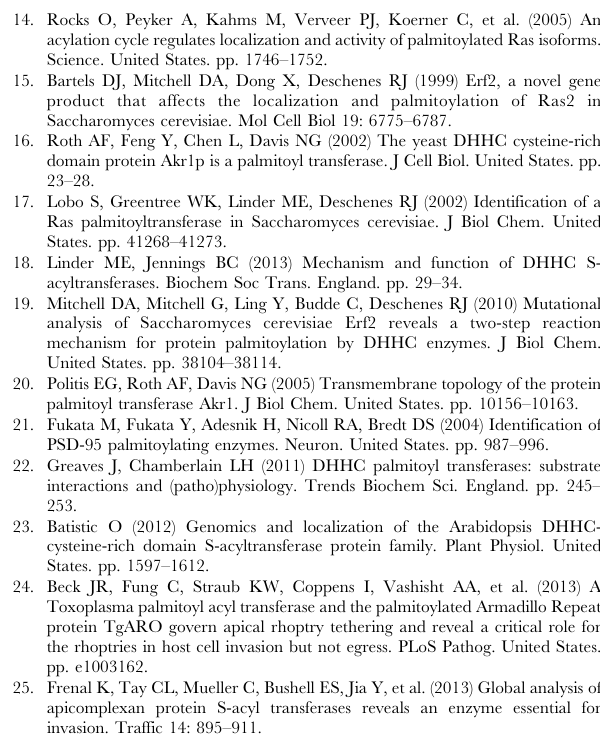
Figure S1 Expression of HCNCp-V5 in Giardia growing and encysting parasites. Western blotting performed on total protein extracts from hcncp-V5 transgenic trophozoites (T) or hcncp-V5 transgenic encysting trophozoites (ET). Expected size is indicated in brackets. Relative molecular weights of protein standards (kDa) are indicated on the left. Figure S2 The zoomed subclade containing gla_8619, gla_6733, gla_1908, and gla_8711 (A) or EAA36893 (B) from the phylogenetic tree presented in figure 4. Sequence taxonomic identity is displayed with colors as described in figure 4. Figure S3 The zoomed subclade containing gla_9529 from the phylogenetic tree presented in figure 4. Sequence taxonomic identity is displayed with colors as described in figure 4. Figure S4 The zoomed subclade containing gla_16928 (A) or gla_96562 (B) from the phylogenetic tree present- ed in figure 4. Sequence taxonomic identity is displayed with colors as described in figure 4. Figure S5 The zoomed subclade containing gla_2116 from the phylogenetic tree presented in figure 4. Sequence taxonomic identity is displayed with colors as described in figure 4. Figure S6 Differential expressions of Giardia dhhc genes in trophozoites and encysting parasites by semi-